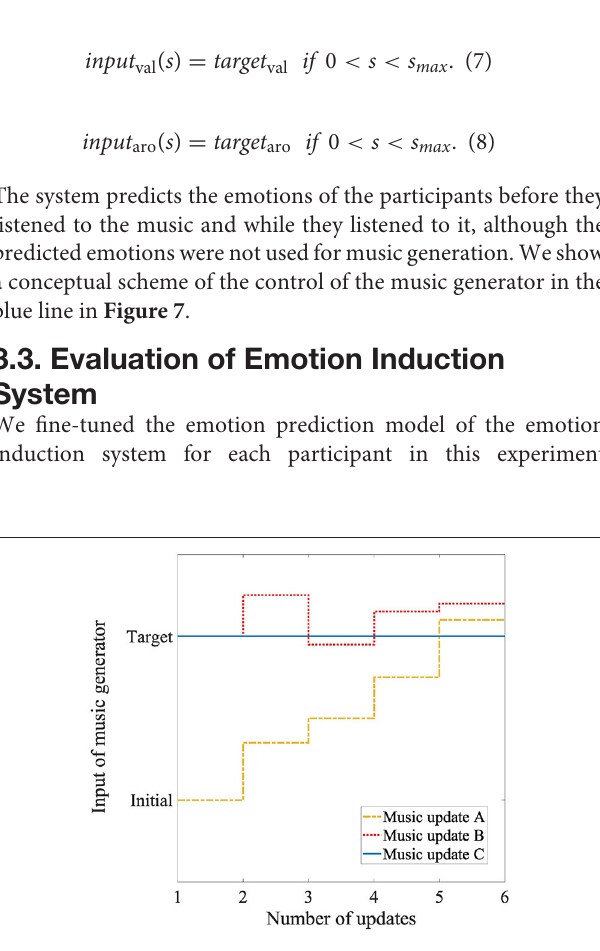
FIGURE 7 | Conceptual scheme of control of music generator using three methods: Target denotes target emotion for emotion induction. Initial denotes participant’s emotion before listening to music.